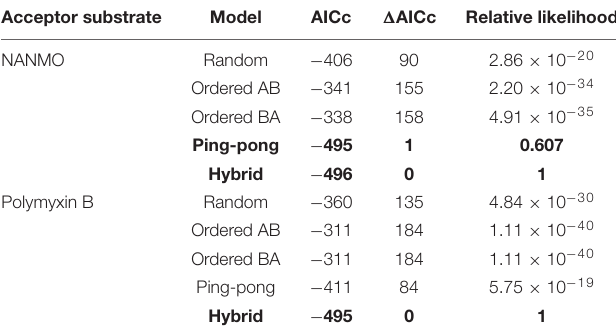
TABLE 3 | Analysis of fitting for kinetic mechanism models toward both NANMO and polymyxin B. Acceptor